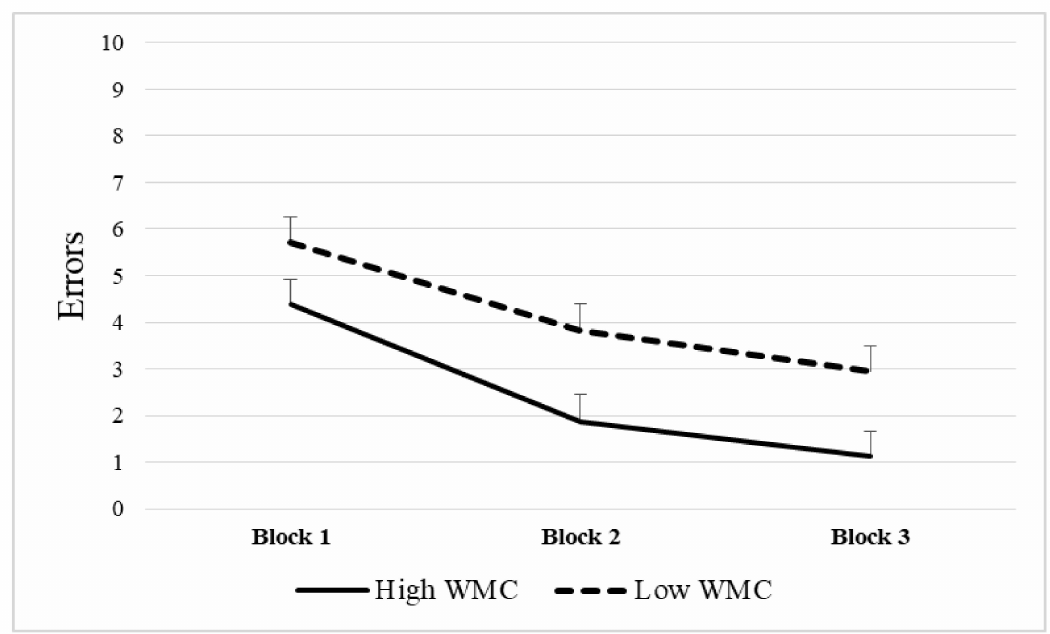
Figure 5. Mean number of errors in The Boxes Room task according to working memory capacity (WMC). Note that higher WMC was related to better performance in the task through the di ff erent blocks of trials. Mean +